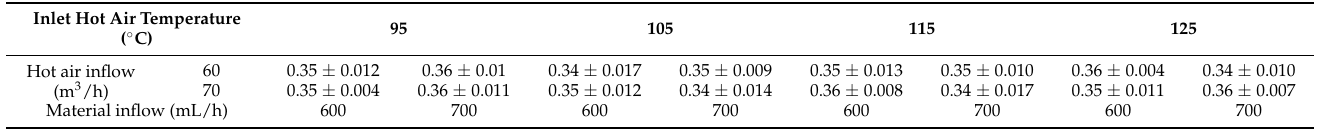
Table 3. Dry-basis content of bound water